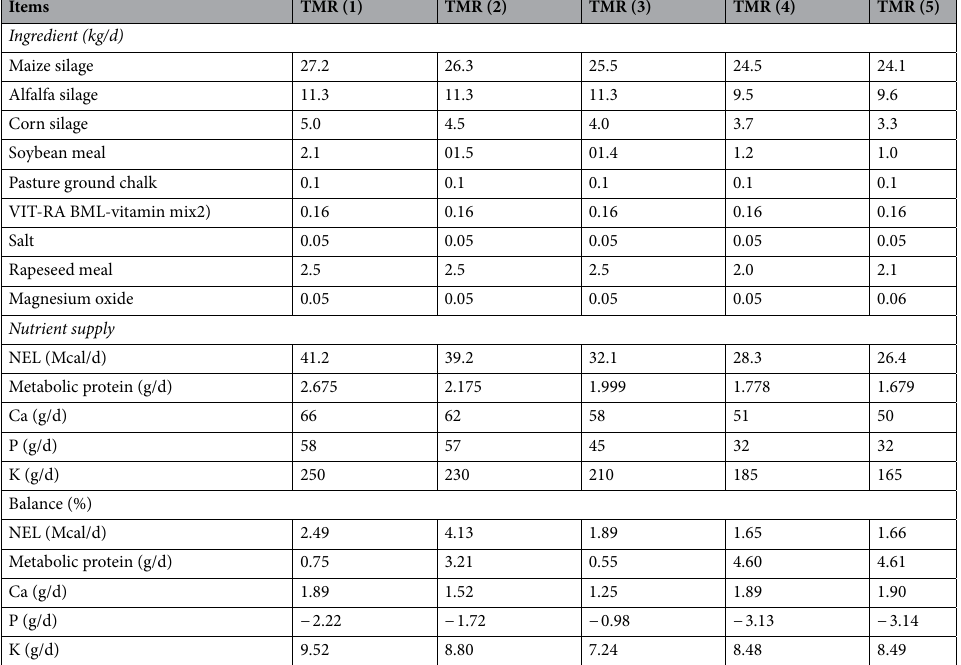
Table 2. The ingredient composition of the total mixed ration (TMR) and nutrient balance for cows at different stages of lactation. The cows were fed a basal diet (TMR) ad libitum, and the TMR was formulated using a system developed by the French National Institute for Agricultural Research (INRA) to provide adequate milk energy and milk production for cows of 628 ± 34 kg. TMR Total mixed ration, NEL Net energy for lactation. 1) TMR 1, group I, 38 kg/day; TMR 2, group II, 44 kg/day; TMR 3, group III, 30 kg/day; TMR 4, group IV, 25 kg/day; TMR 5, group V, 19 kg/day. 2) Vitamin premix; VIT-RA BML (values per kg): 150 g